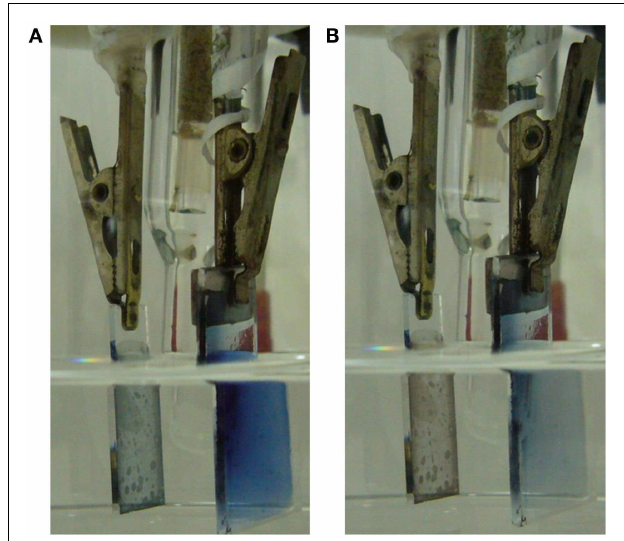
FIGURE 2 | Experimental cell: left side ITO counterelectrode, right side PEDOT–PSS film casted on glass showing a transversal Pt foil on the top allowing the clamp electrical contact . A half of the Pt foil and most of the conducting polymer was coated with two layers of transparent Parafilm®. (A) Reduced PEDOT–PSS film. (B) Oxidized PEDOT–PSS